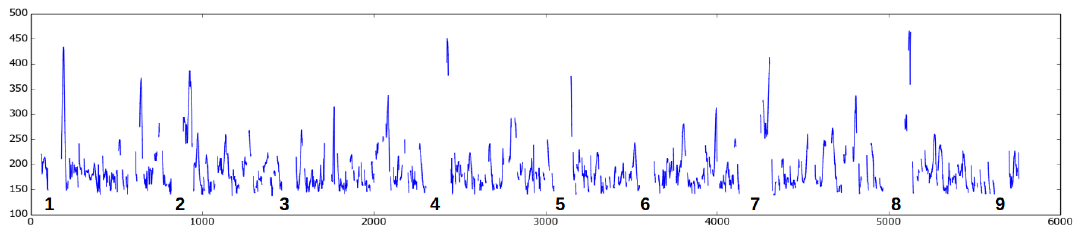
Figure 4: Pitch track (just under 60 seconds) of part of a news item in a BBC news broadcast, read by a female newsreader, from the Aix-MARSEC corpus (Auran et al. 2004). Pauses are numbered